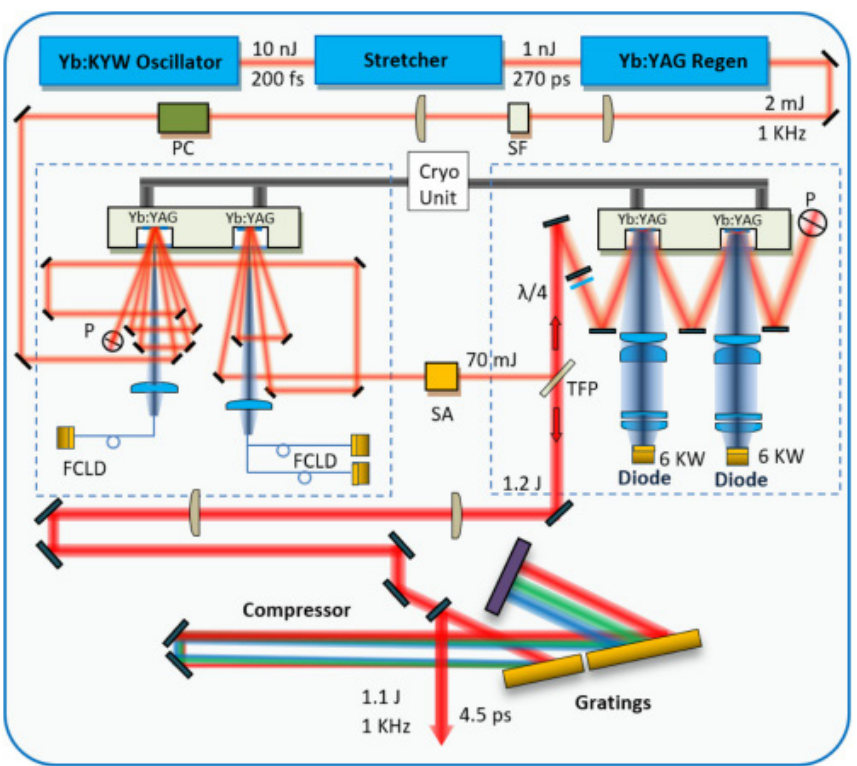
Figure 10. Schematic diagram of the diode-pumped high energy CPA laser system: Regen, regen- erative amplifier; SF, spatial filter; PC, Pockels cells; FCLD, fiber-coupled laser diodes; SA, serrated aperture; TFP, thin-film polarizer; P, periscope [52]. [Reprinted/Adapted] with permission from [ref #] © The Optical Society. OSA requires a special citation format.